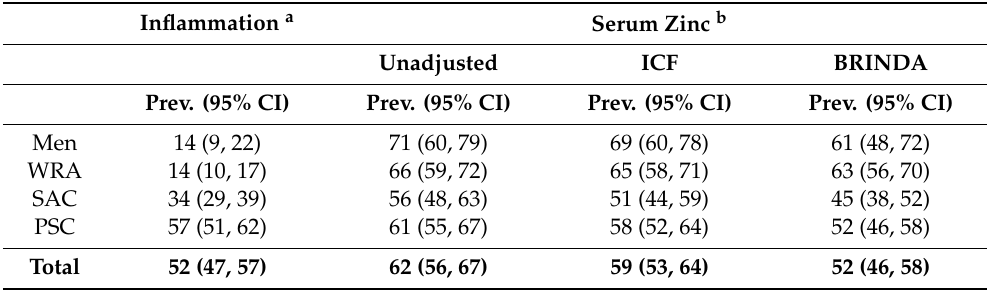
Table 5. Prevalence estimates of serum zinc deficiency and inflammation in Malawi presented across multiple age